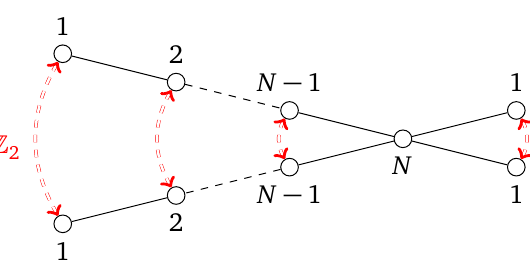
Figure 7: Wreathed quiver for SQCD-like theories with gauge group (cid:221) SU ( N )